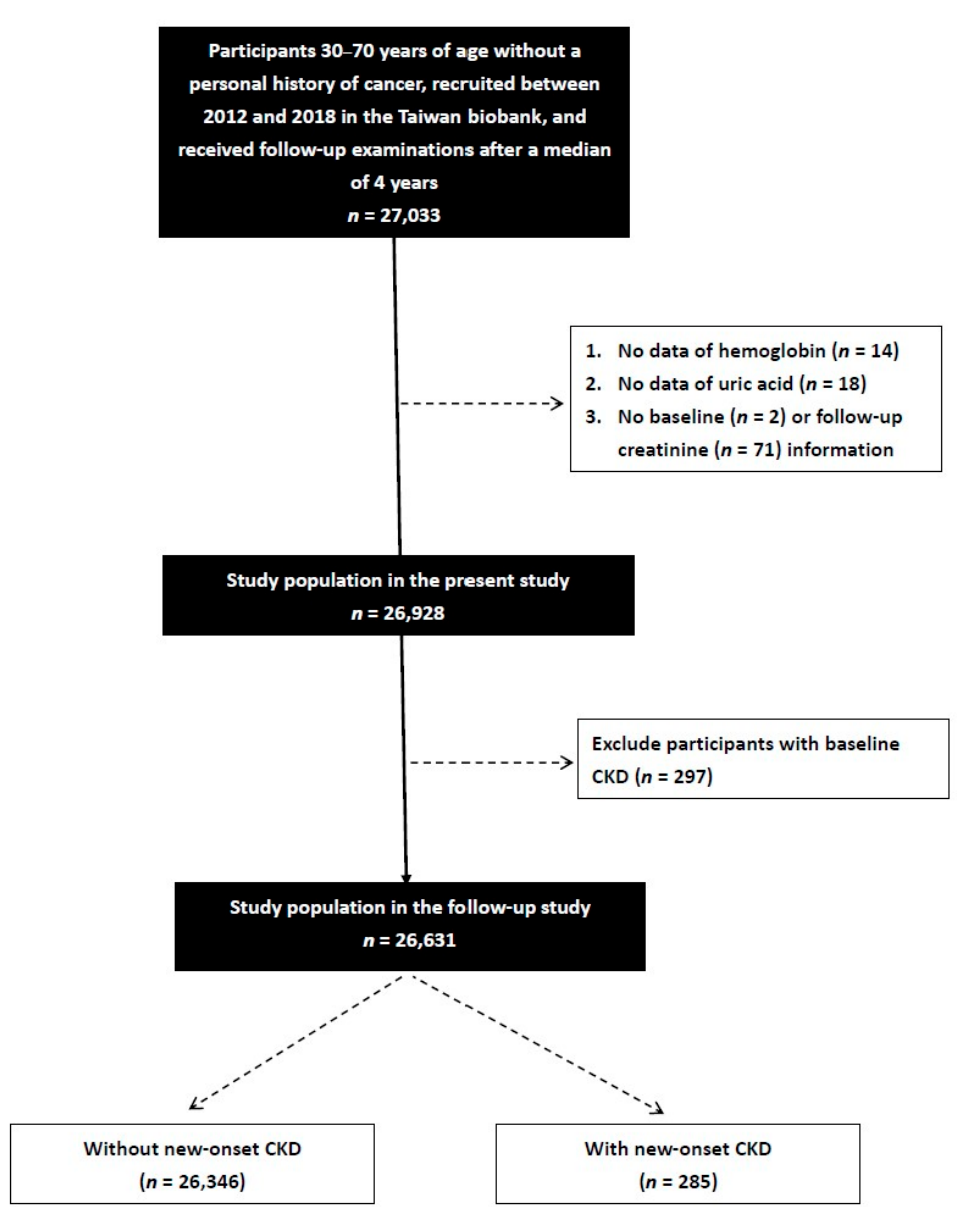
Figure 1. Flowchart of study population.